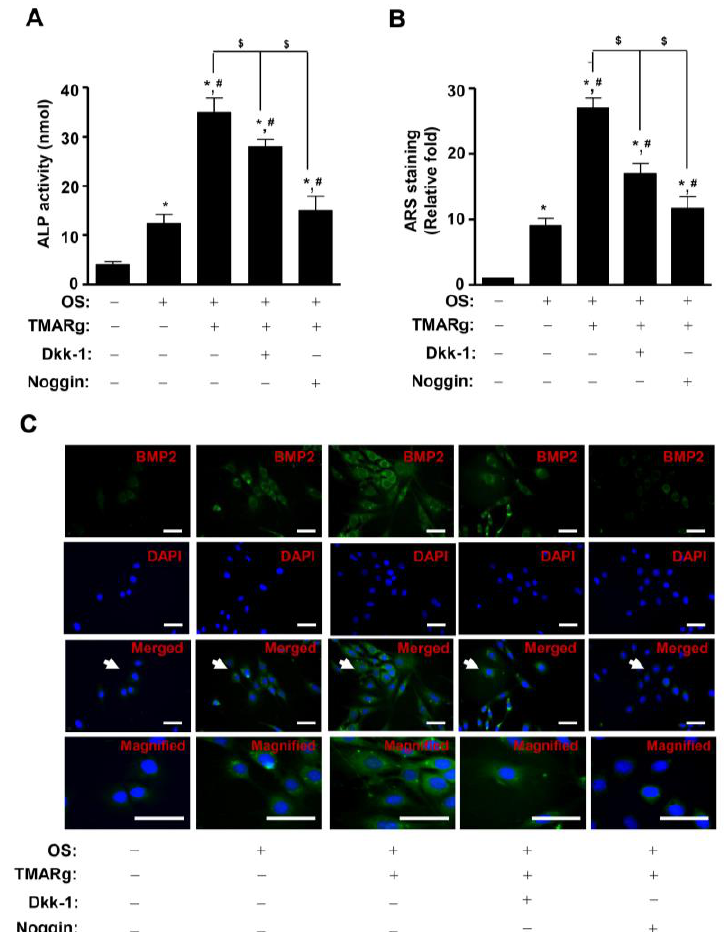
Figure 7. Inhibition of BMP2 and β-catenin signaling attenuates osteoblast differentiation using TMARg treatment. ( A ) The cells were seeded onto 48-well plates and were cultured in OS with TMARg (30 µM) in the absence or presence of Dkk-1 (0.5 µg/mL) and noggin (10 µg/mL) for 5 days. ALP activity was measured by using ALP activity assays. ( B ) The cells were seeded onto 24-well plates and differentiated for 14 days. Mineralized nodule formation was assessed using ARS staining. ( C ) BMP2 was immunostained with rabbit anti-BMP2 antibody, followed by Alexa-Fluor 488-conjugated secondary antibody (green). Then, the cells were counterstained with DAPI (blue). The bottom panels show the magnification of the merged images. The arrow indicates the magnified region. Scale bar: 50 µm. The data are representative of the results of three independent experiments. Data represent the means ± SEMs of experiments. *, p < 0.05 was considered significantly different, compared to the control. #, p < 0.05 was considered significantly different, compared to the OS. $, p < 0.05 was considered significantly different, compared to the OS + TMARg.